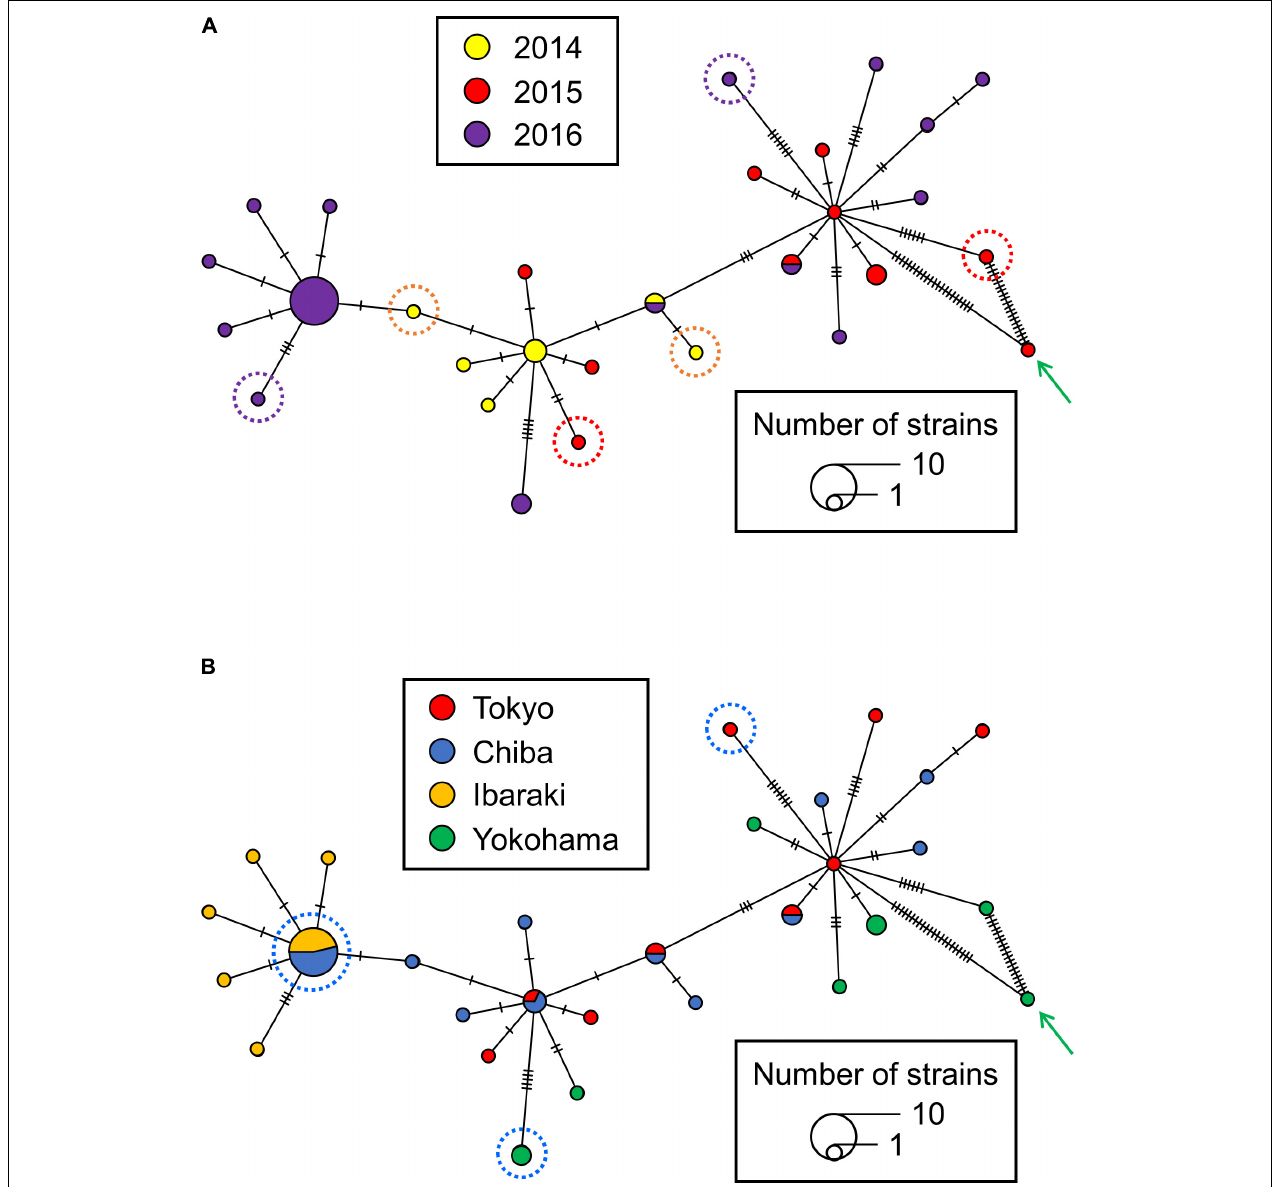
FIGURE 4 | A minimum spanning tree (MST) reconstructed from the single nucleotide polymorphism (SNPs) from S . Chester isolated in the Kanto region of Japan. The colors of the nodes in panels (A,B) indicate the years and areas in which the S . Chester stains were isolated, respectively. (A) The isolates surrounded by orange, red and purple dotted lines show the maximum pair-wise distances between two isolates in 2014, 2015, and 2016, respectively. (B) The isolates surrounded by blue dotted lines show the maximum pair-wise distances of the isolates from Tokyo and Chiba and those of the Tokyo and Yokohama isolates. A green arrow indicates isolate 29149. A crossing bar on a connecting line indicates one